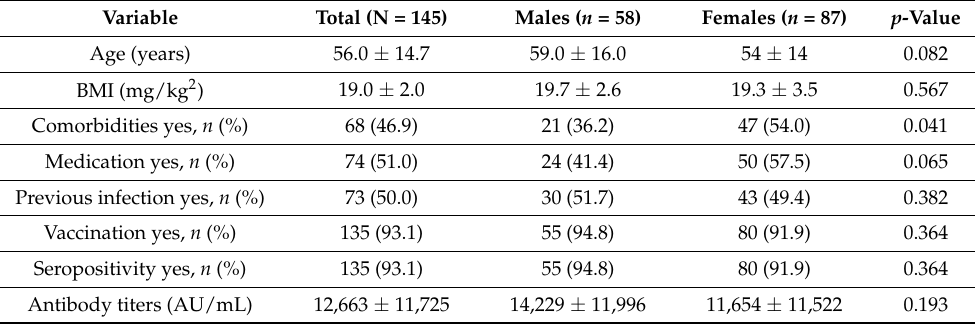
Table 1. Characteristics of the study population stratified by gender (N = 145).